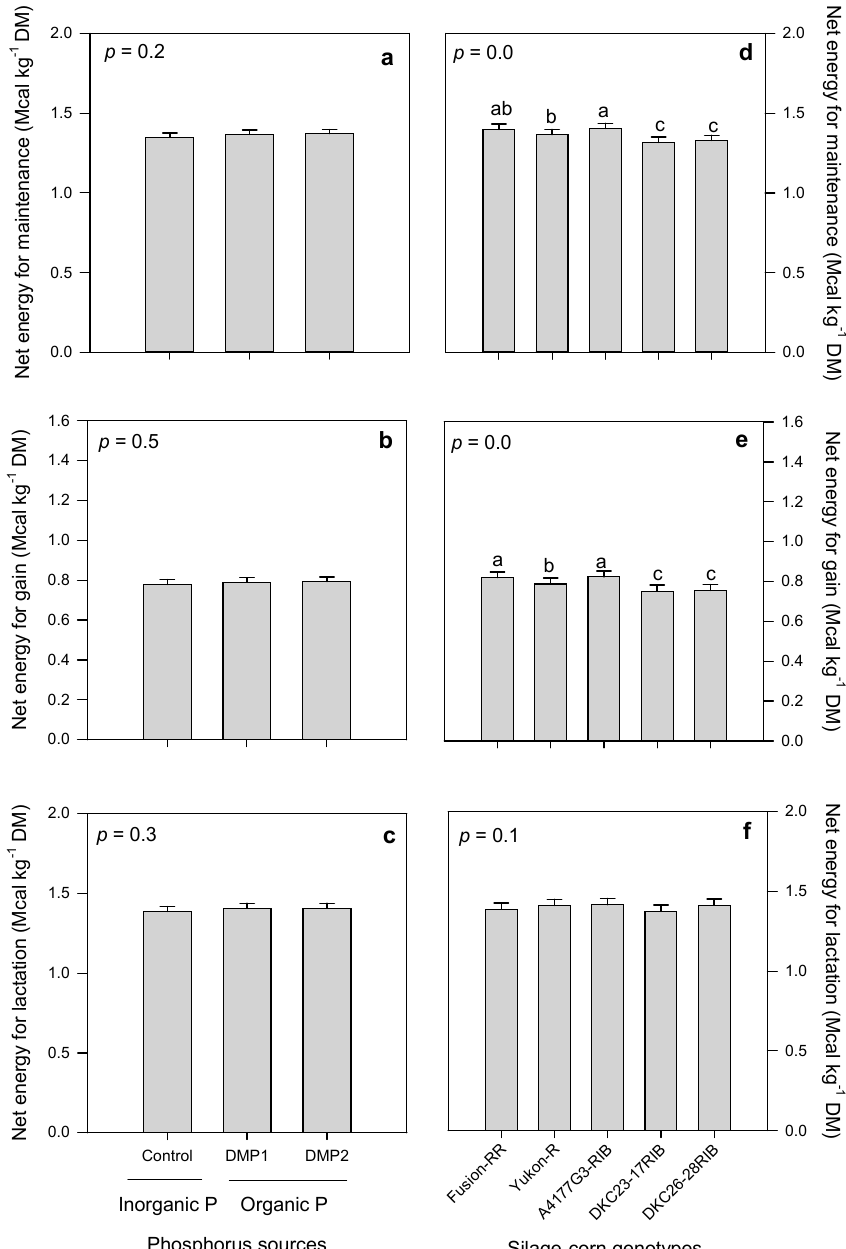
Figure 6. Effects of inorganic and organic phosphorus amendments on forage energies: NEM ( a ), NEG ( b ), and NEL ( c ). Variations in NEM ( d ), NEG ( e ), NEL ( f ) among silage-corn genotypes grown in boreal climate. Each bar represents mean of three replications ± SE.